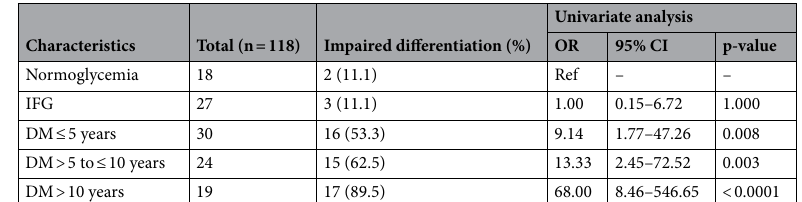
Table 2. Univariate logistic regression analysis of osteogenic differentiation impairment across different stages of dysglycemia.